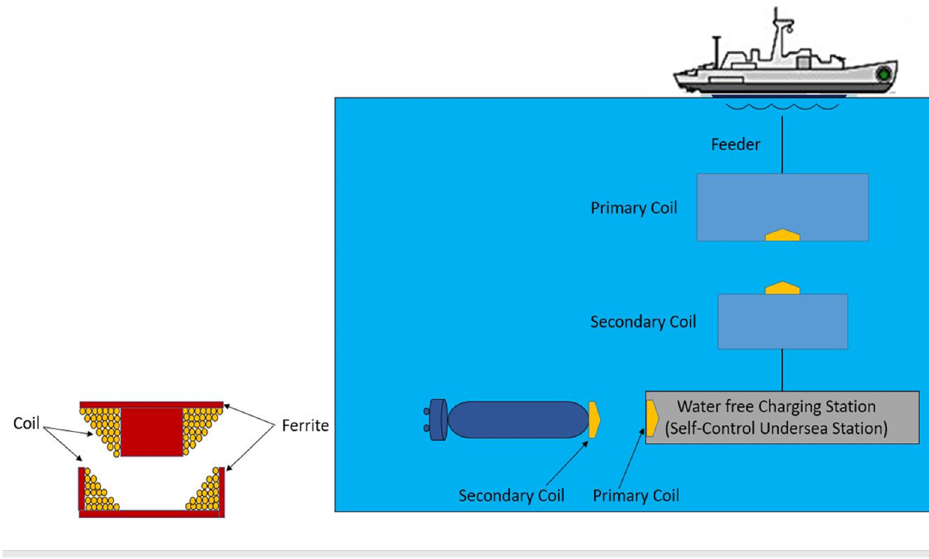
Figure 23. WPT System by Tohuku University and NEC company.